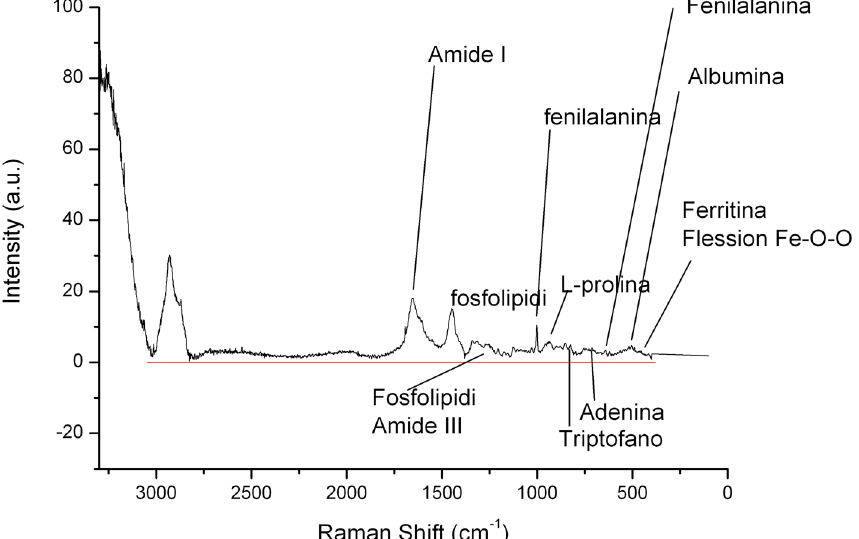
Figure 2. Average Raman spectrum of sera from control group (CG) subjects (n = 11) in the spectral range of 3100–400 cm −1 , after having performed a baseline correction of each of them in order to compensate eventual technical and/or sample variations, and having normalized them to the total integrated area. The spectrum put in evidence the main typical protein vibrational modes, which derive from the polypeptide backbone (amide bands) and from aromatic and non-aromatic amino acid residue side